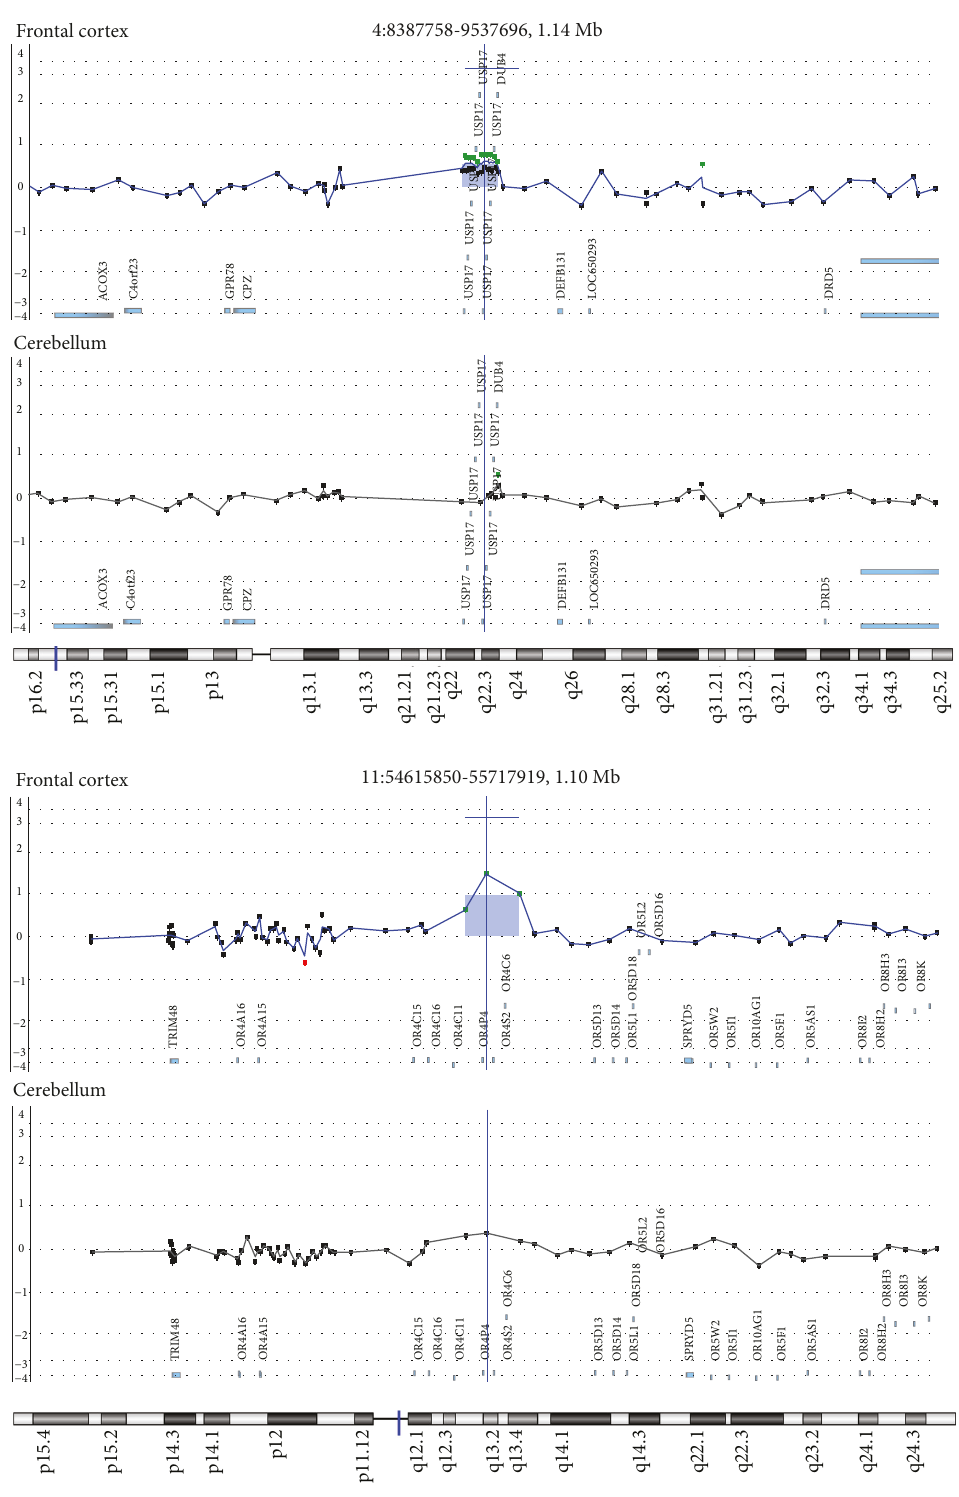
Figure 3: Unique DNA copy number variations (CNVs) from neural tissues. Two examples of somatic duplications that are present in the frontal cortex but absent in the cerebellum. Images extracted from Genomic Workbench